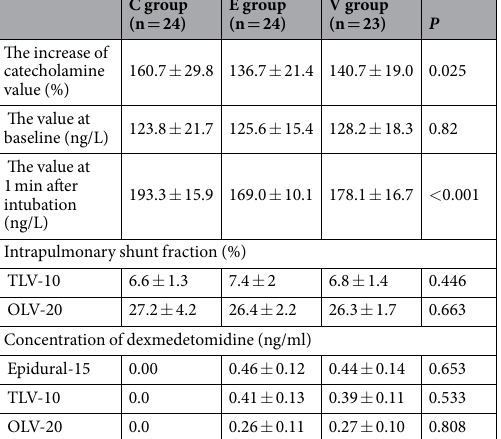
Table 2. The increases of catecholamine value, intrapulmonary shunt fraction and the concentration of dexmedetomidine in all groups. Epidural-15, 15 min after epidural or intravenous infusion of dexmedetomidine; TLV-10, 10 min after two-lung ventilation; OLV-20, 20 min after one-lung